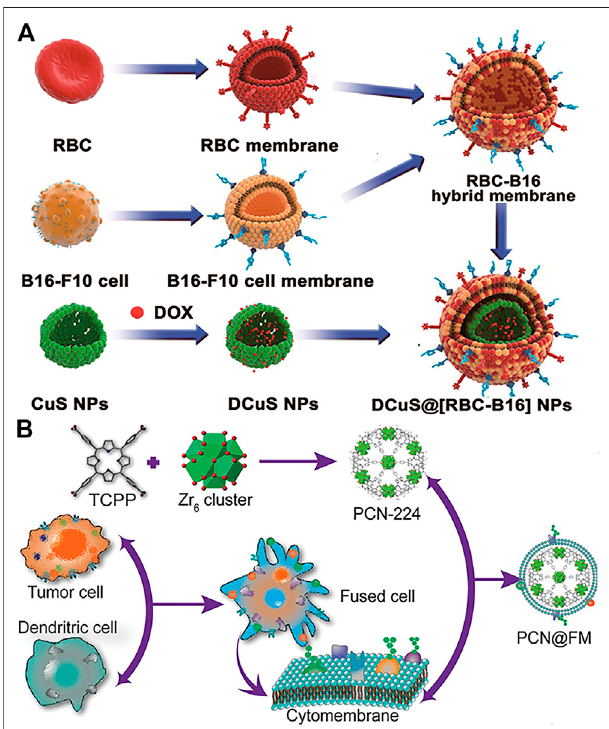
FIGURE 2 | (A) Schematic of preparations of DCuS@[RBC-B16] NPs. The fusion membranes of RBCs and B16F10 cells are encapsulated on DOX- loaded hollow copper sul fi de nanoparticles (DCuS NPs) (Reproduced with permission from Wang et al., (2018a)). (B) Illustration of preparation process of PCN@FM for monotherapy (Reproduced with permission from Liu et al. (2019a)).